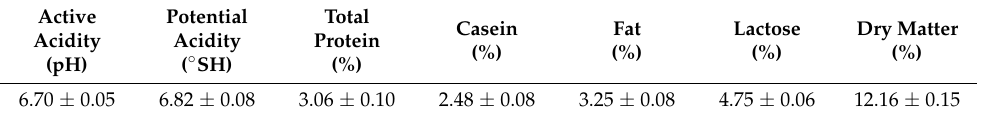
Table 2. Results of physico-chemical analysis of pasteurized organic milk obtained from the dairy used in the production of yoghurts (mean ± SD). Active Acidity (pH)